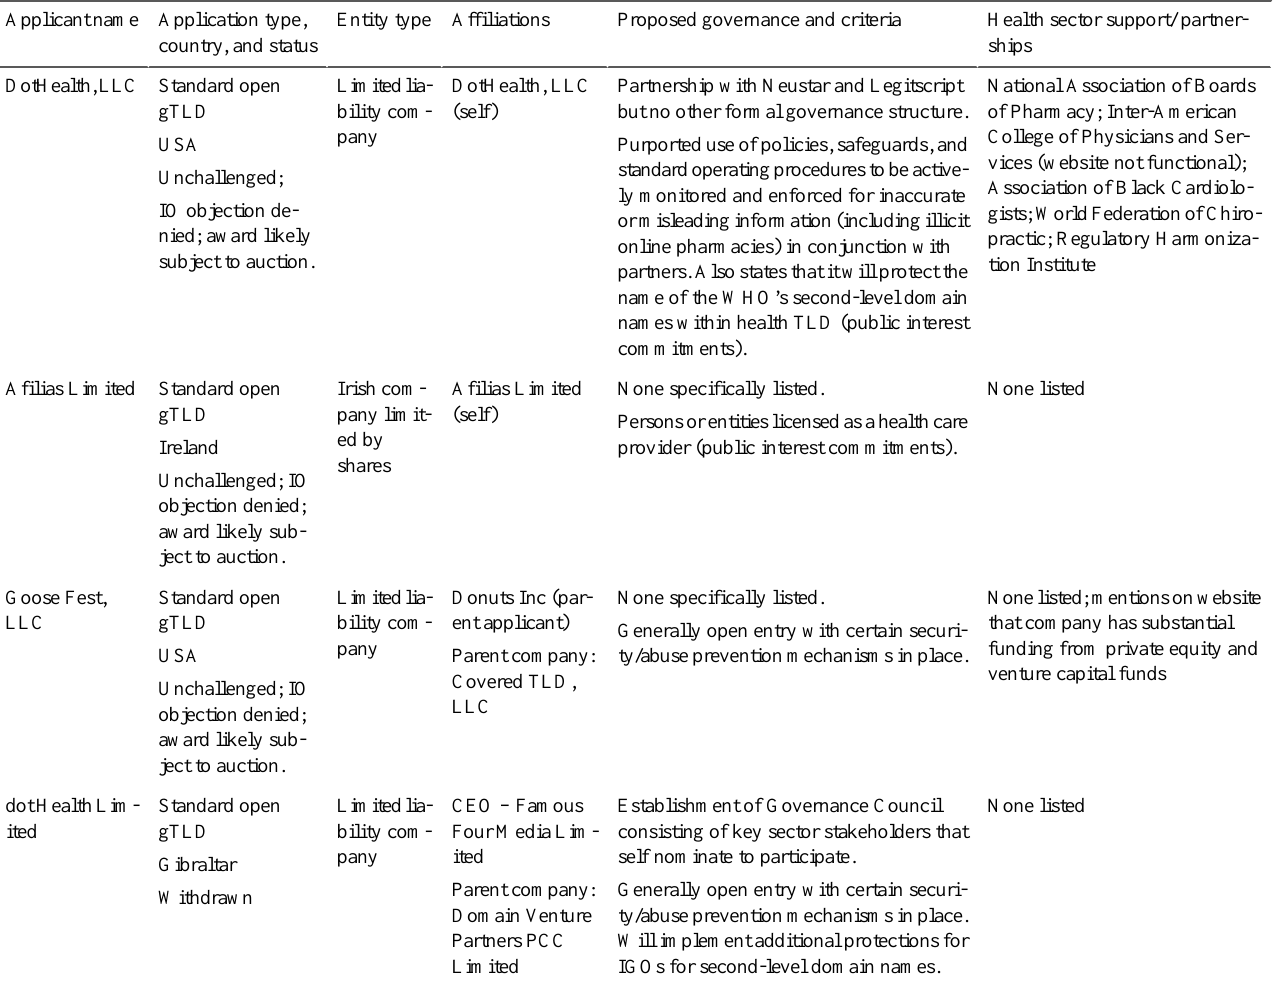
Table 1. health gTLD